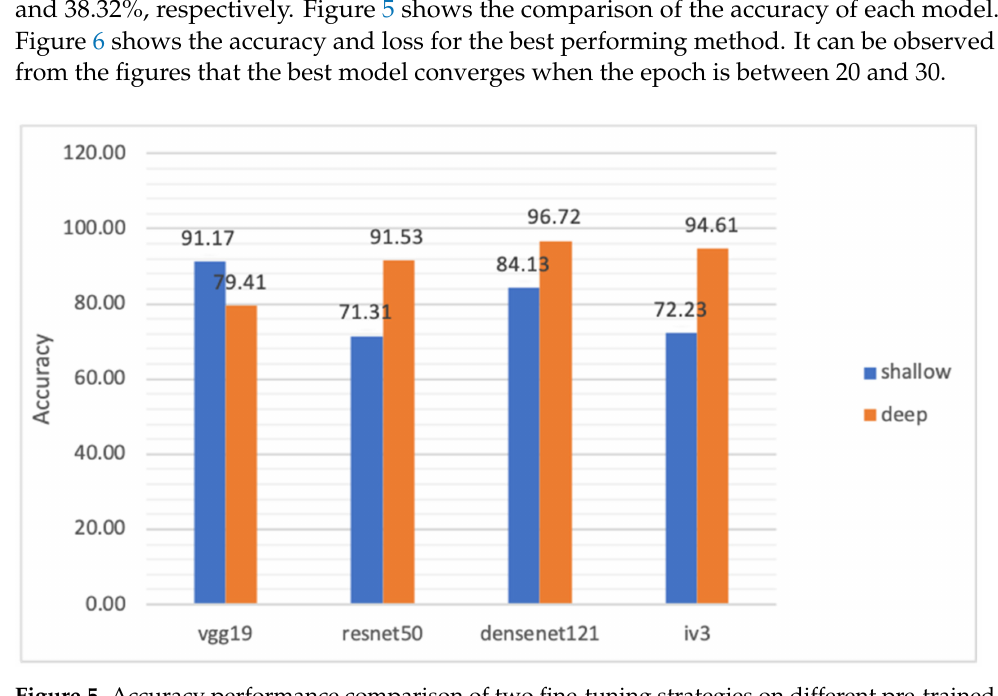
Figure 5. Accuracy performance comparison of two fine-tuning strategies on different pre-trained CNN